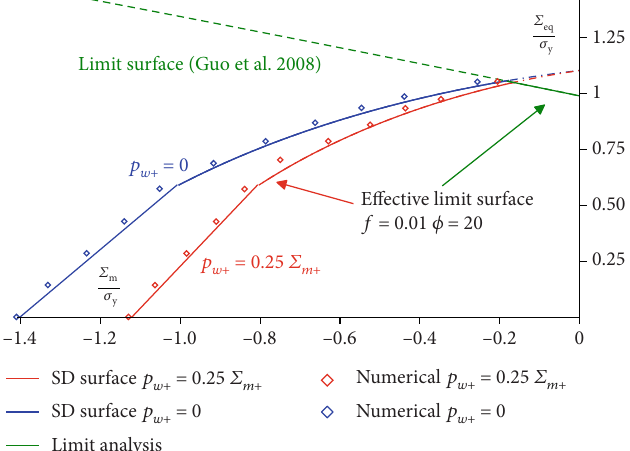
: 25 Σ m + . The friction w + = 0 and 0